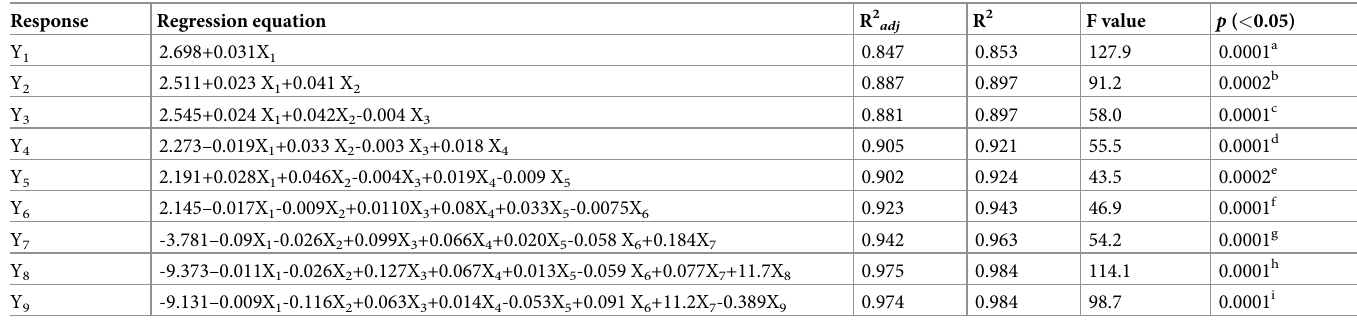
Table 8. Stepwise regression among different variables for predicting wheat ( Triticum aestivum L.) grain yield.